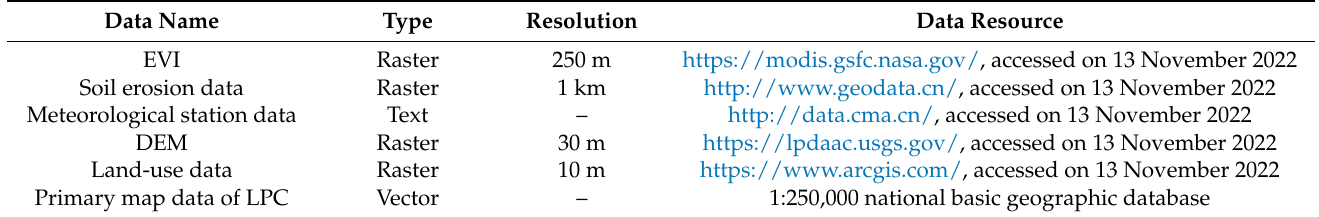
Table 1. Details of data used in this study.